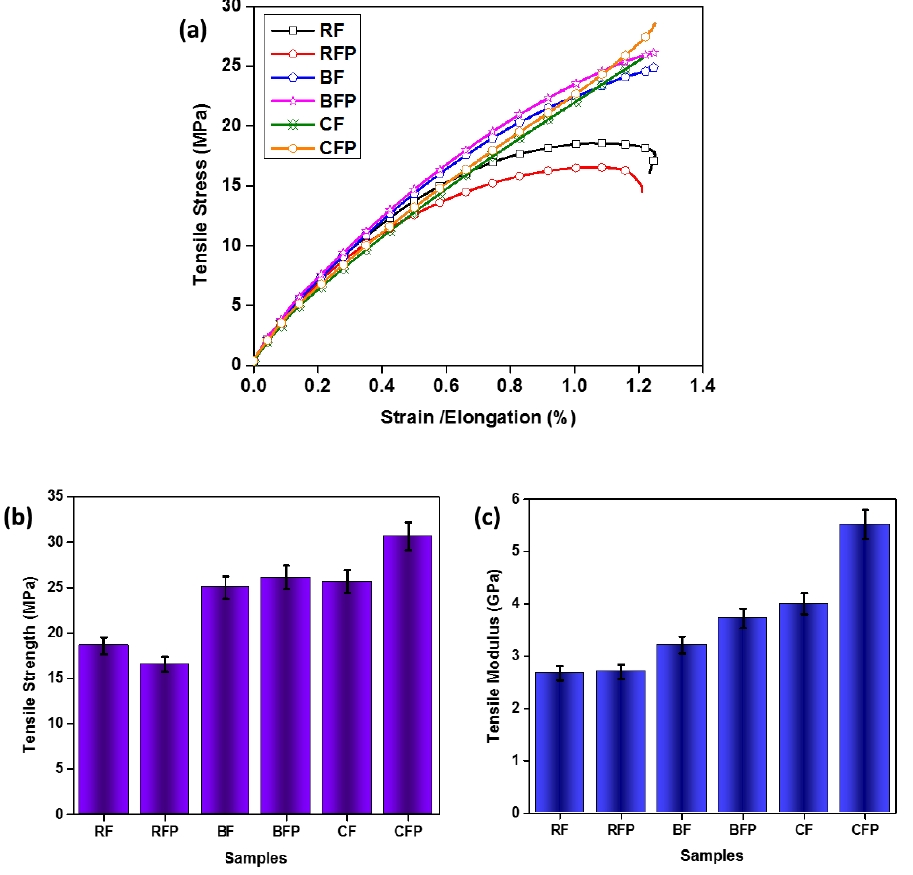
Figure 2. The behavior of the composites in tensile testing ( a ) Stress–strain behavior ( b ) Tensile Strength ( c ) Tensile Modulus.